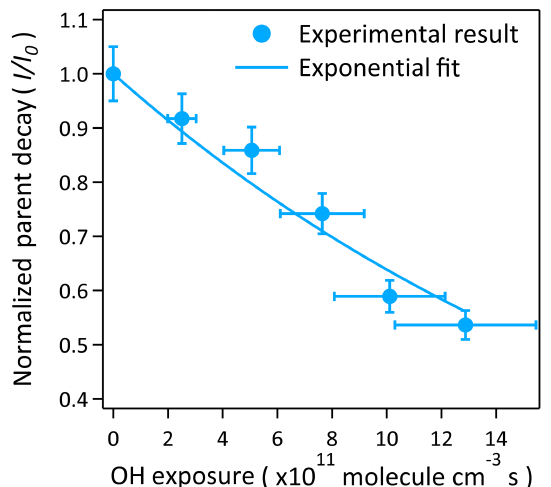
Figure 8. The kinetic evolution of HSO 4 − and SO 4 − as a func- tion of OH exposure in the heterogeneous OH oxidation of sodium ethyl sulfate. The small uncertainty in ion intensity measurement for SO 4 − is not visualized in the